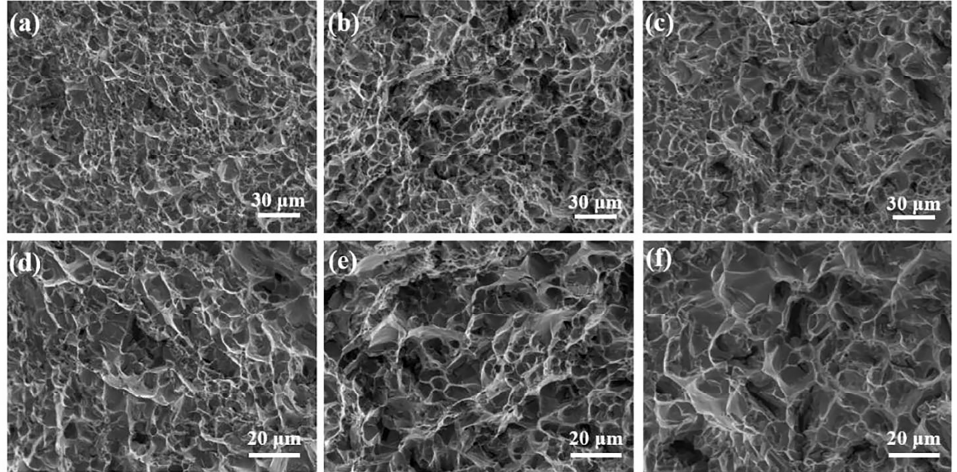
Figure 11. Fracture morphology of the as-extruded Al-9.5Si-1.5Cu-0.8Mn-0.6Mg alloy: ( a , d ) C0 alloy; ( b , e ) C1 alloy; ( d , f ) C2 alloy.